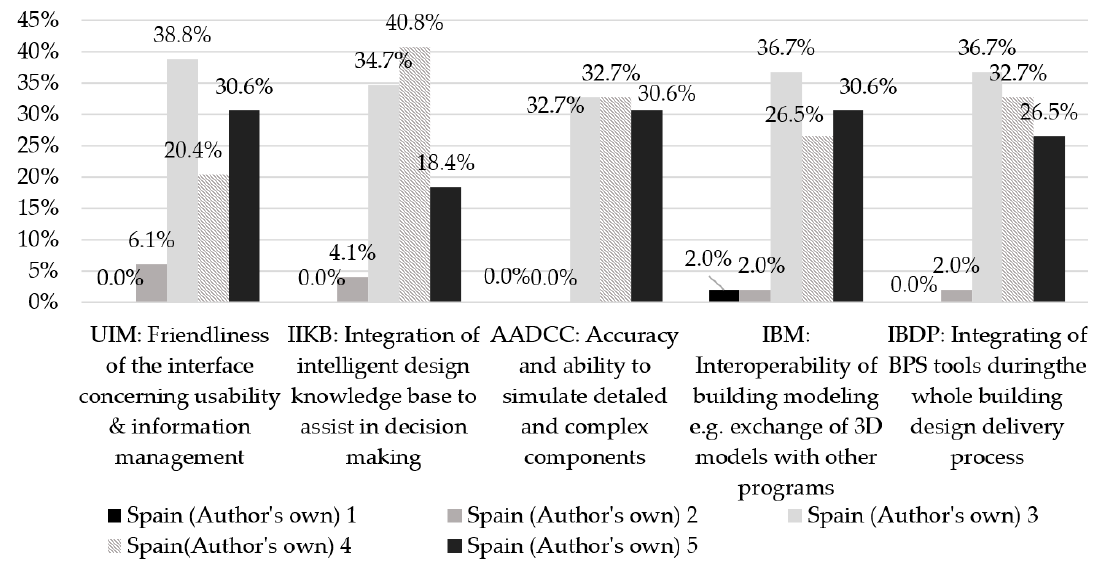
Figure 7. Priorities in selecting BPS tools. Comparison of different groups of respondents from Spain considered in this study (values 1 to 5). Level of importance: low (1), high (5). (Addressed only to BPSTs users).